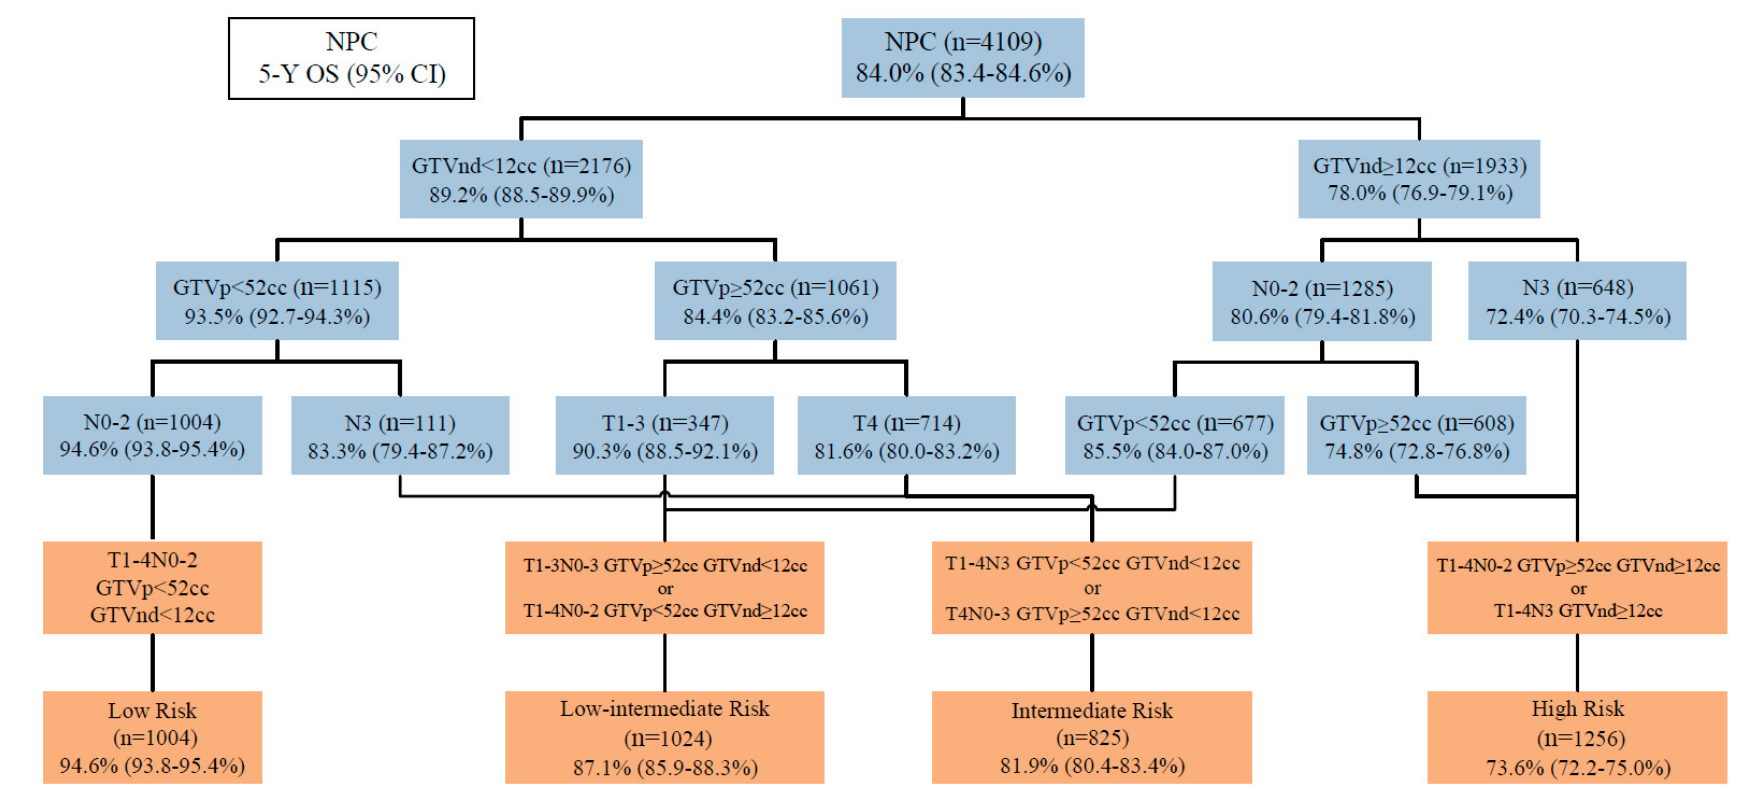
Figure 2. The T-N-volume (TNV) risk stratifications derived by recursive partitioning analysis (RPA).